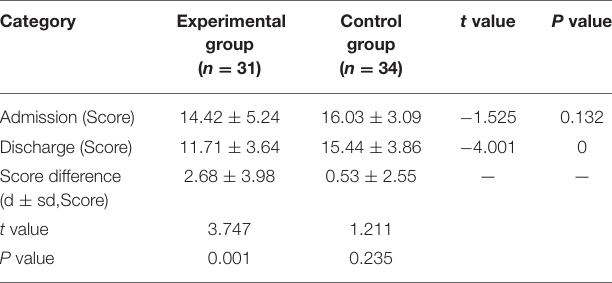
TABLE 4 | Comparison of hads score between the two groups.